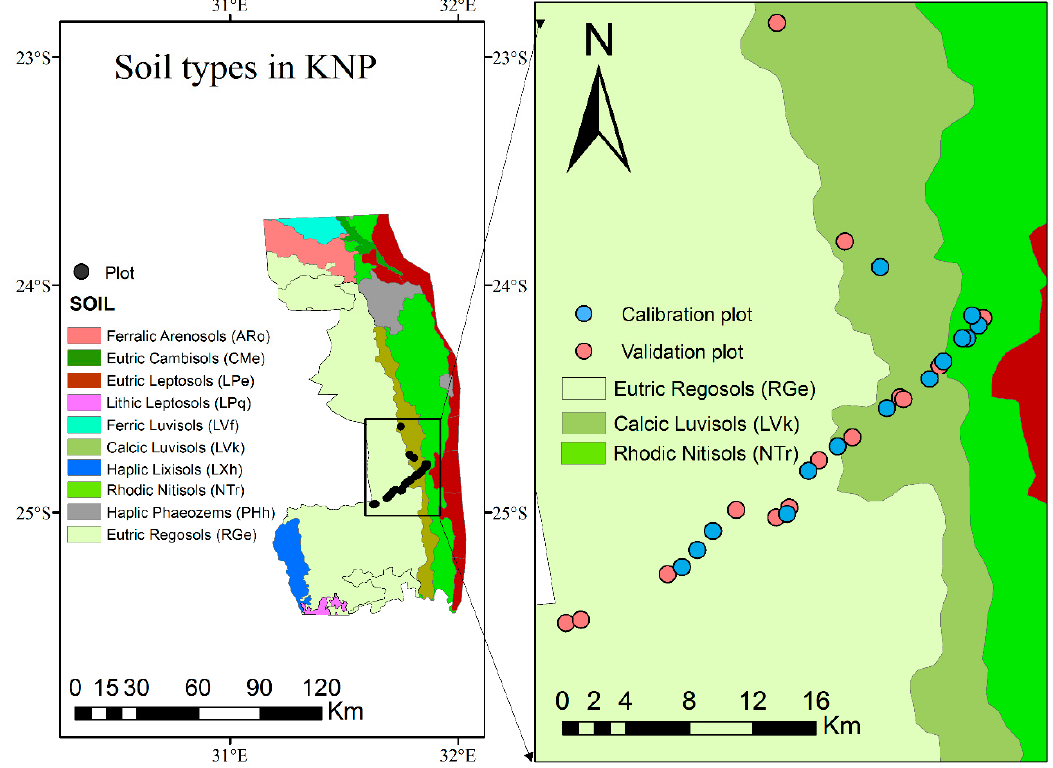
Figure 2. Soil types in KNP, the main soil types in the field plot area, field plot data (the blue and pink points indicate calibration and validation plots, respectively.